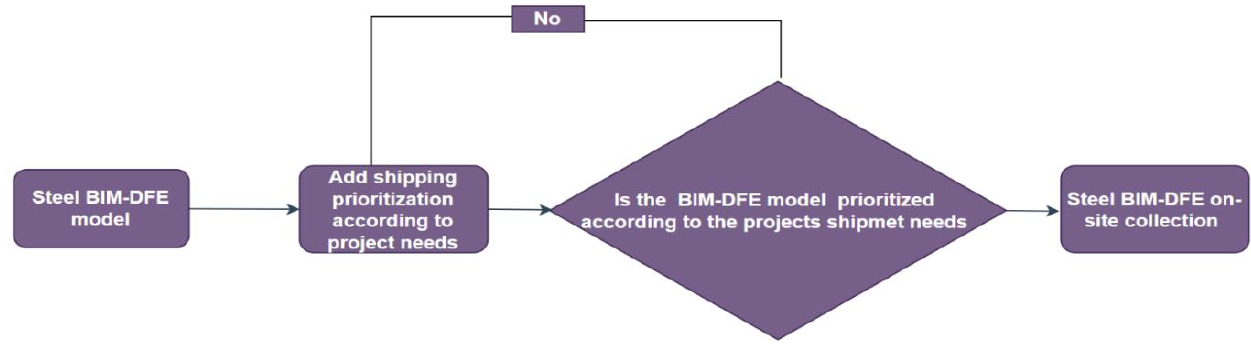
Figure 18. Transportation by BIM-DFE.